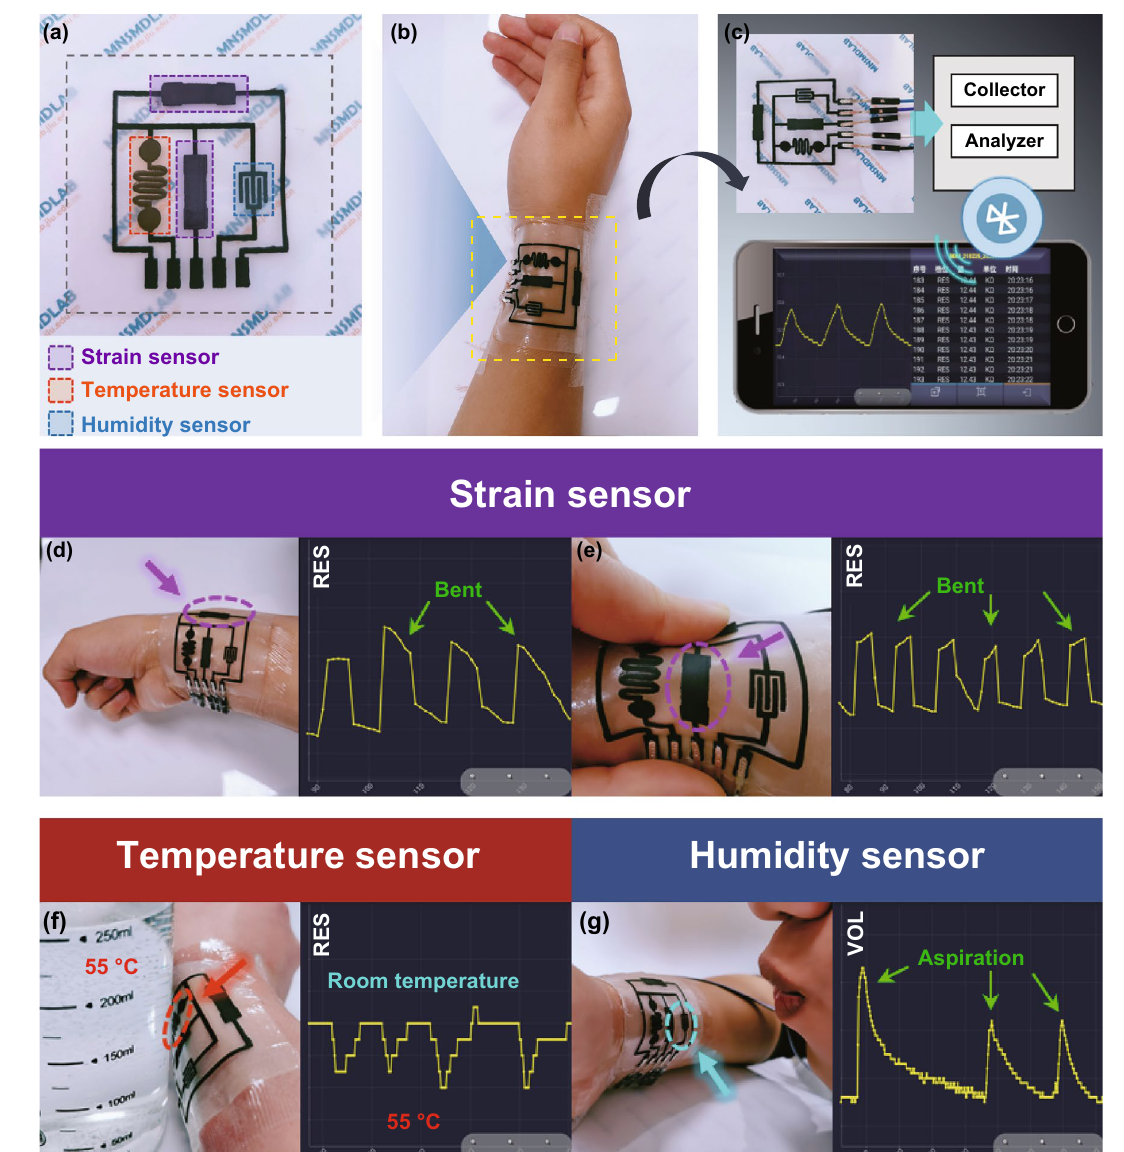
Fig. 6 a Photograph of the e-skin containing strain sensors, temperature sensor and humidity sensor. b Photograph of the e-skin attached to the wrist. c Schematic illustration of wireless monitoring system of the e-skin. d Real-time response signals of wrist movement measured by the sensing unit and displayed on a phone. e Real-time response signals of skin deformation tested by the sensing unit and displayed on a phone. f Varieties in ambient temperature engendered by a cup with hot water near the temperature sensing unit and displayed on a phone. g Changes in ambient humidity caused by exhaling to the humidity sensing unit and displayed on a